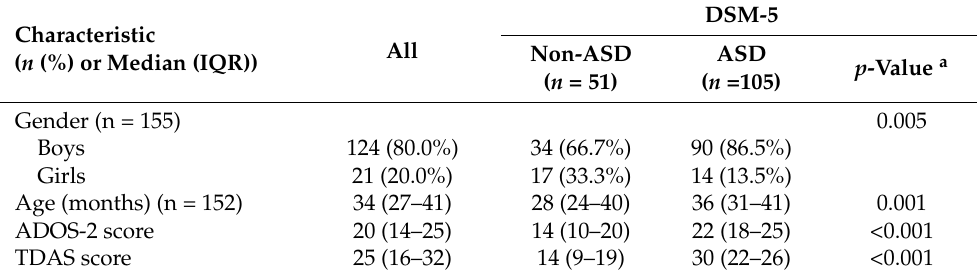
Table 1. Characteristics of the participants ( N = 156).